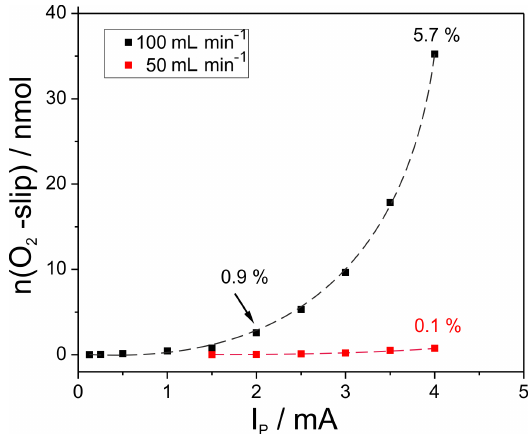
Figure 3. Plot of the current pulse in cell one (black) and the titra- tion currents in cell two (blue, red). Furnace temperature 25 ◦ C; cell temperatures 750 ◦ C.